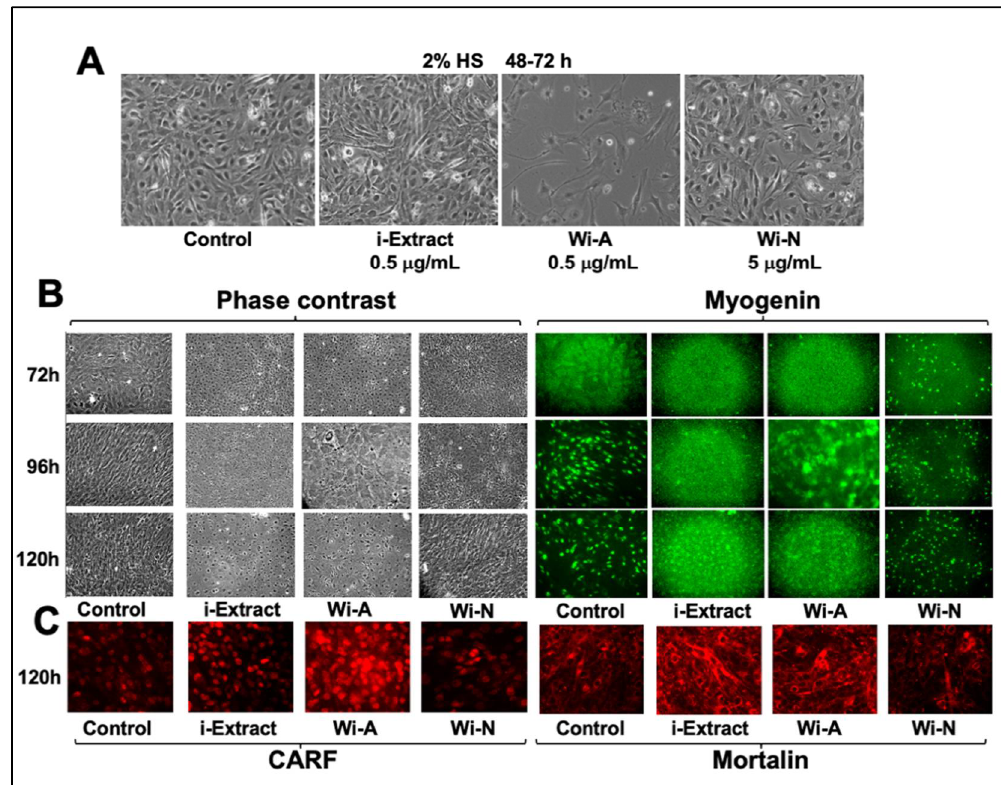
Figure 1. Effect of Ashwagandha leaf extract and purified withanolides on C2C12 differentiation. ( A ) C3 clone was differentiated in the control (2% HS) and the medium supplemented with bioactive compounds derived from Ashwagandha (i-Extract, Wi-A, and Wi-N). Phase contrast, myogenin ( B ), CARF, and mortalin immunostaining ( C ) of C3 clone treated with i-Extract, Wi-A, and Wi-N.